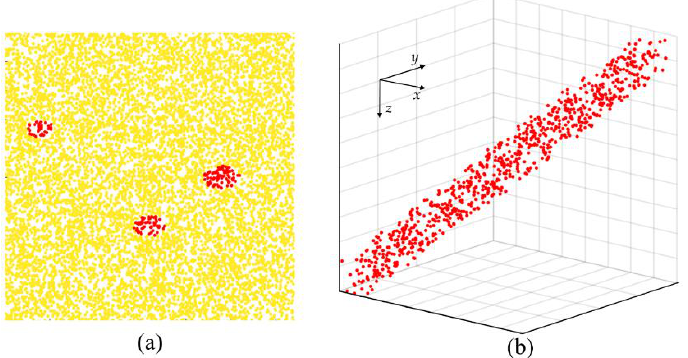
Figure 1. Schematic of the 2D and 3D images containing scatterers used in the simulations. ( a ) 2D cross section containing three blood vessels (red colored dots) surrounded by “solid” tissue (yellow); ( b ) 3D volume in which the diagonal cylinder represents the vessel filled with moving blood particles. The rest of the volume for 3D is also filled by scatterers imitating the “solid” tissue, but these scatterers are not shown. Scatterers of the “solid” tissue have the same concentration and scattering strength as in the vessel for both 2D and 3D datasets.